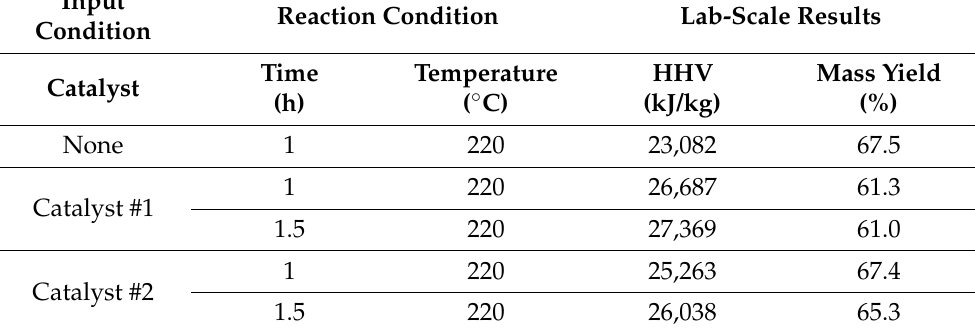
Table 4. Comparison of calorific value and mass yield after catalytic HTC of waste wood at the laboratory